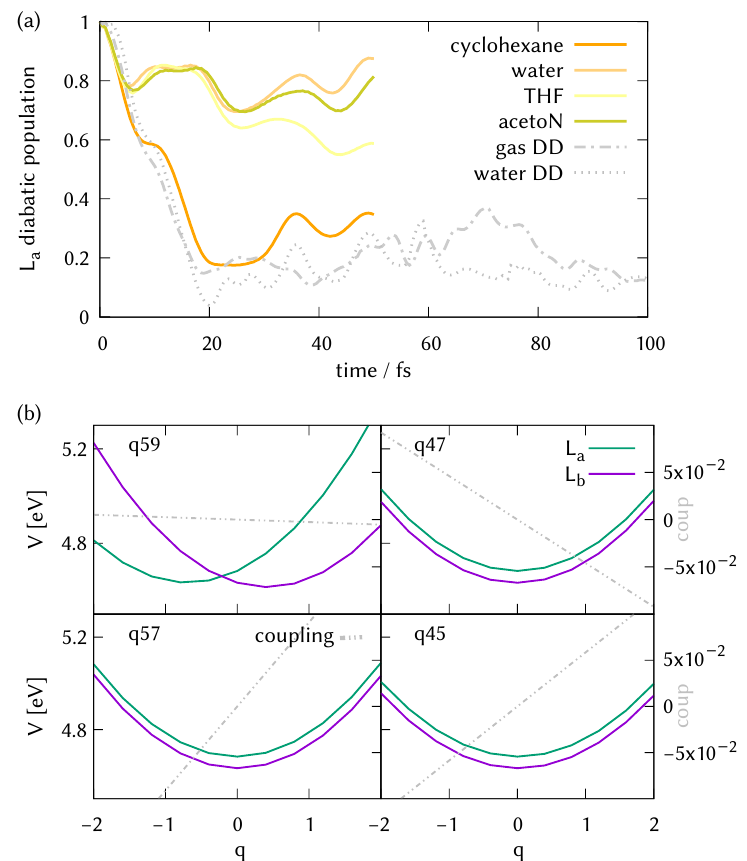
Figure 9. ( a ) Fully converged ML-MCTDH diabatic electronic populations of DMABN in solvent from dynamics starting in the L a state. Based on the pt(SS+LR)-PCM/wB97X-D3/cc-pVDZ level